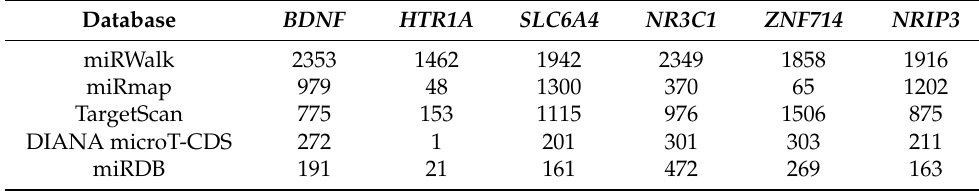
Table 2. Number of predicted miRNAs involved in each target gene